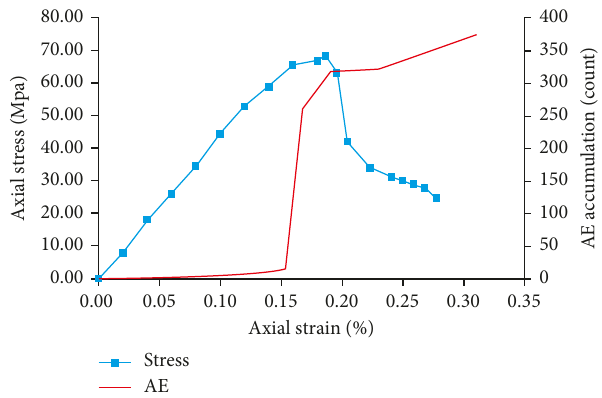
Figure 15: The stress-strain curve and the AE counts during the fracture